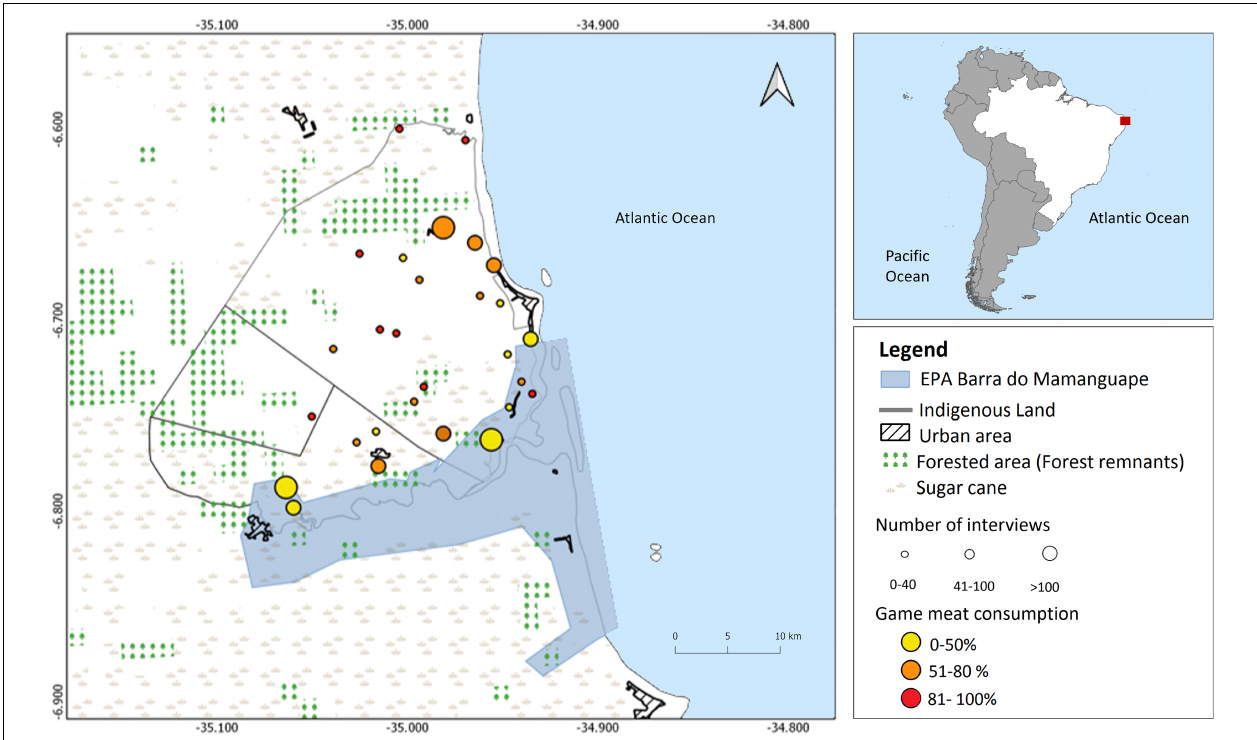
FIGURE 1 | Map of the study area portraying the 28 indigenous villages in the Potiguara territory where the study was carried out. Solid dots indicate the villages of the interviewed students. Dot sizes are proportional to the number of interviewed students from each village. Circle colors denote the number of students that have consumed game at least once in their lifetime in each village, ranging from yellow (smaller number) to red (greater number). Map generated using QGIS; Datum: SIRGAS2000. Source: IBGE, Editedin Adobe Photoshop and Elaborated in March